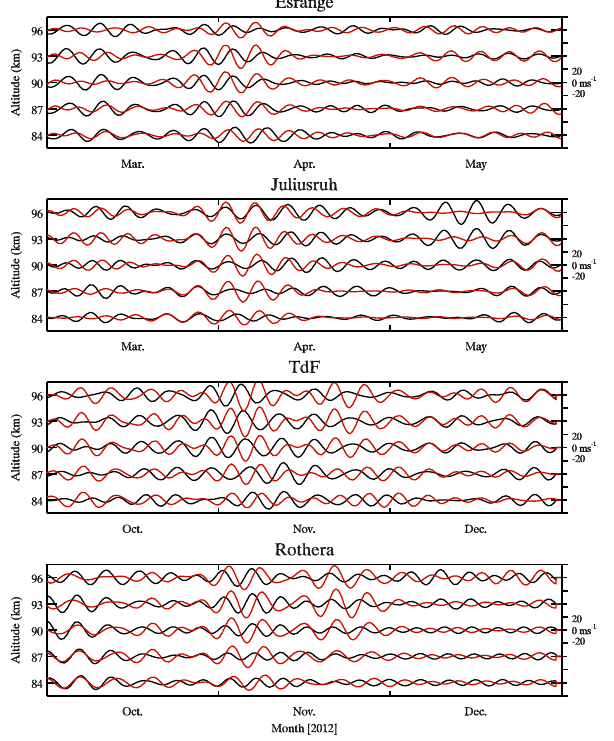
Figure 6. Same as Fig. 4, but from March to May 2012 for Esrange and Juliusruh and from October to December 2012 for Tierra del Fuego and Rothera.